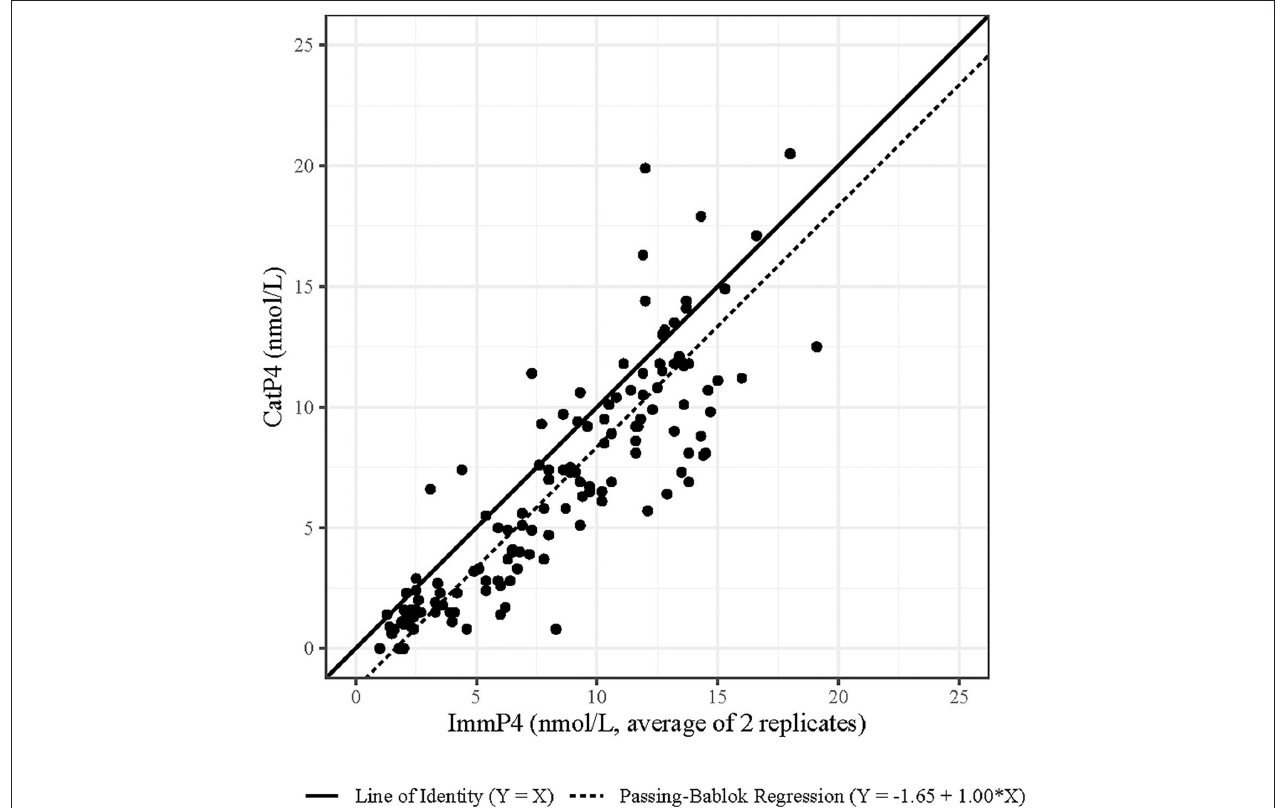
FIGURE 2 | Passing–Bablok regression of 134 progesterone levels measured with the Catalyst and IMMULITE assays.